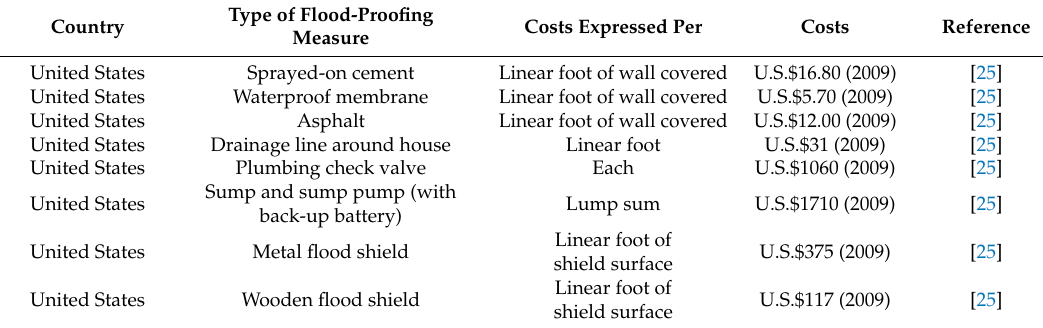
Table A2. Flood-proofing-specific